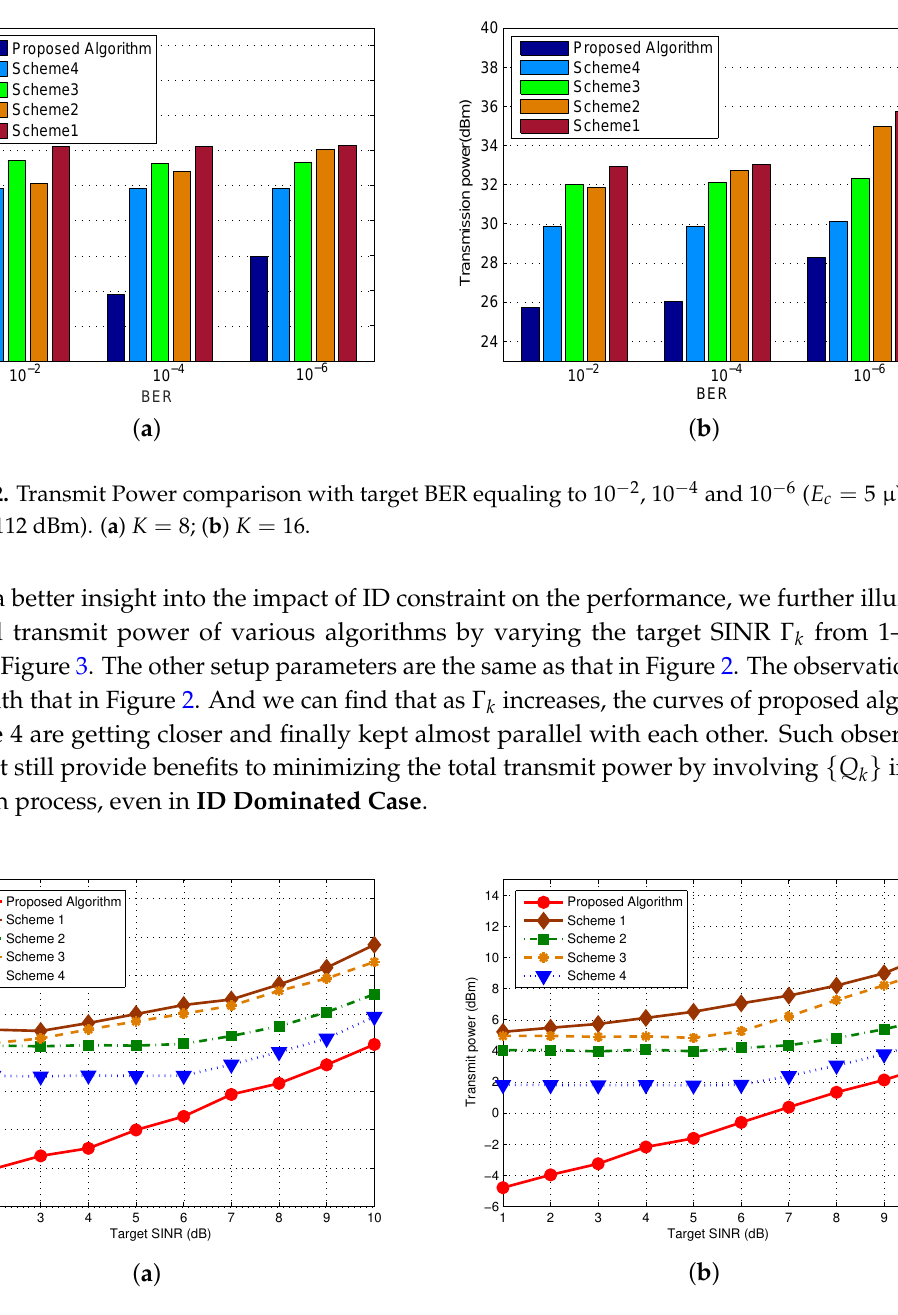
Figure 3. Transmit Power comparison versus target SINR ( E c = 5 µ W, σ 2 = − 112 dBm). ( a ) K = 8; ( b ) K =